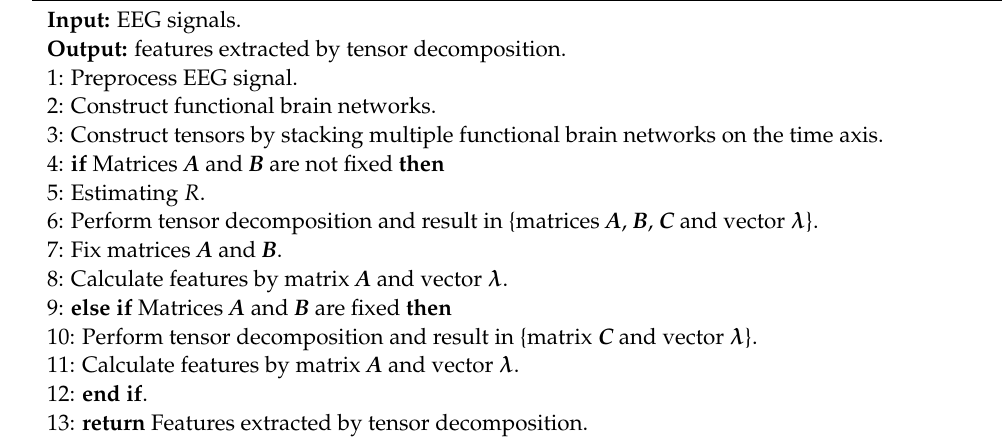
Algorithm 1: Extract Features Using Tensor